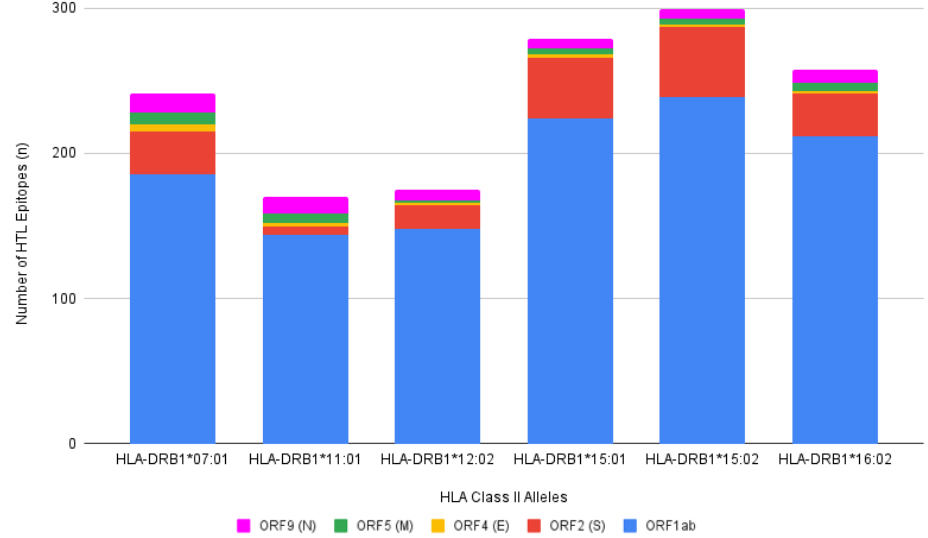
Figure 3. Number of predicted HTL epitopes binding with %Rank less than 1% from SARS-CoV-2 proteins (ORF1ab, ORF2 (S), ORF4 (E), ORF5 (M), and ORF9 (N)) with previously identified HLA Class II DRB1 alleles. A total of 1422 bindings were predicted through NetMHCpan 4.0 with the highest binding recorded by HLA-DRB1*15:02 and the least by HLA-DRB1*11:01, 299 and 170, respectively. ORF1ab is represented by blue color; ORF2 (S) is represented by red color; ORF4 (E) is represented by yellow color; ORF5 (M) is represented by green color; ORF9 (N) is represented by pink color.